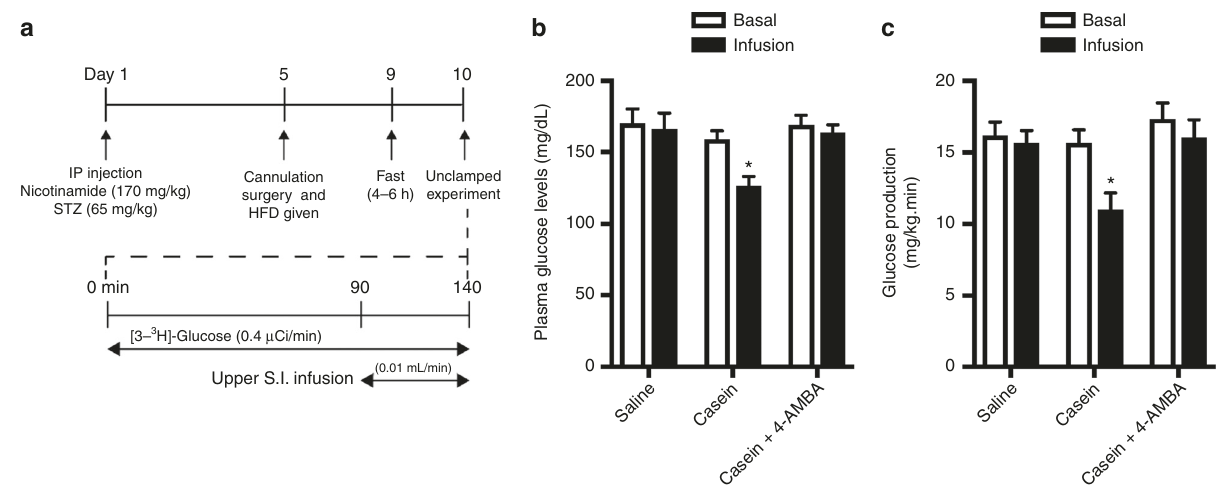
Fig. 6 Upper small intestinal infusion of casein reduces plasma glucose levels and is associated with a reduction in glucose production in hyperglycemic rodents. A non-pancreatic clamp experiment was performed in rats subjected to nicotinamide – streptozotocin (STZ)/HFD-induced hyperglycemia as outlined in a . Plasma glucose levels ( b ) and GP ( c ) were assessed in hyperglycemic rats receiving an upper S.I. infusion of saline ( n = 6), casein ( n = 7), or casein + 4-AMBA ( n = 6). Values are presented as mean ± s.e.m., where basal and infusion represent the average GP of t = 60 – 90 or t = 120 – 140, respectively, and asterisk (*) represents p < 0.05 compared to saline control. Statistical signi fi cance was determined using ANOVA with Bonferonni